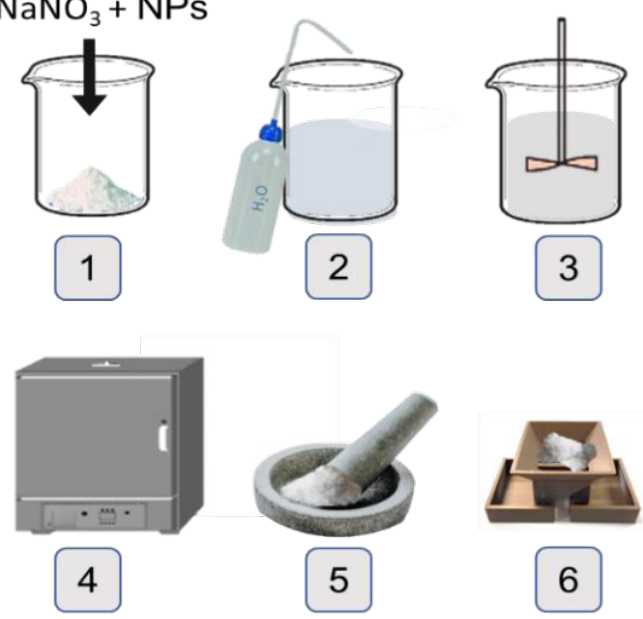
Figure 1. Schematic representation of the two-step nanofluid synthesis.